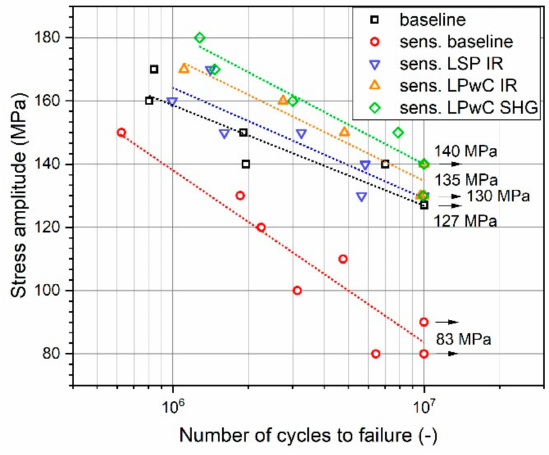
Figure 8. S–N curves of LSP treated sensitized AA5083 after 3-point bend test in 3.5% NaCl solution. Plots for non-sensitized samples (baseline) is provided for comparison.